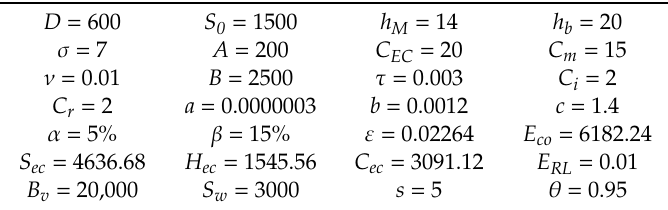
Table 4. Input parameters for Example 2.